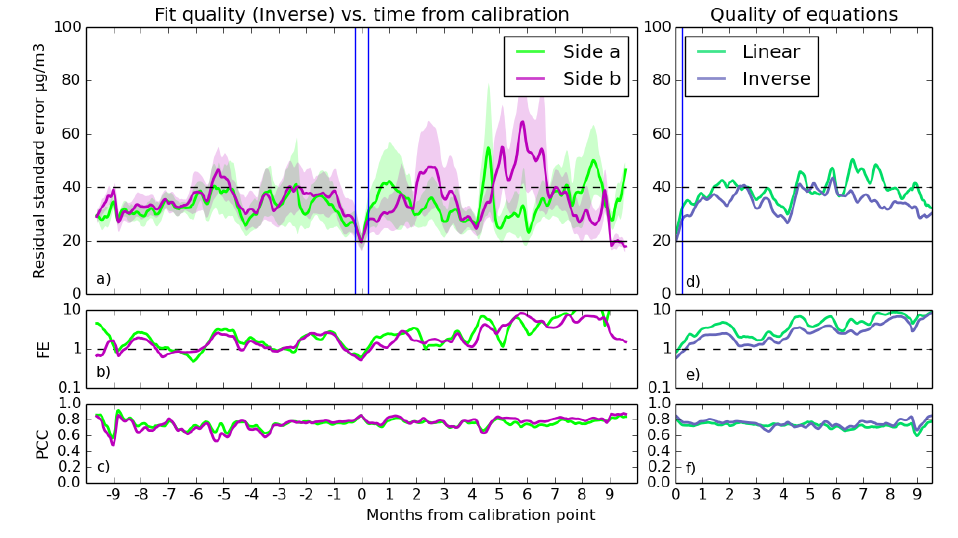
Figure 11. As Figure 10, but for